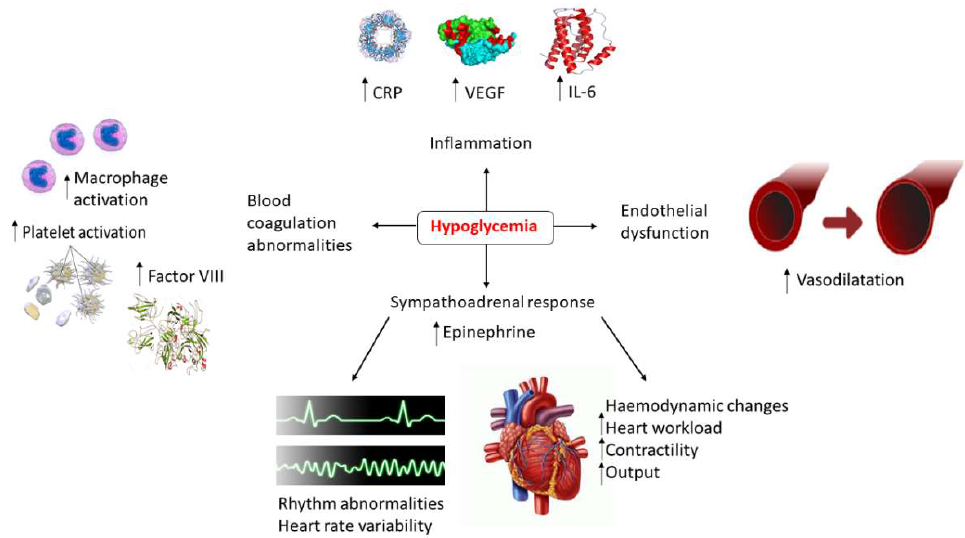
Figure 1. Potential mechanisms linking hypoglycemia to cardiovascular events.